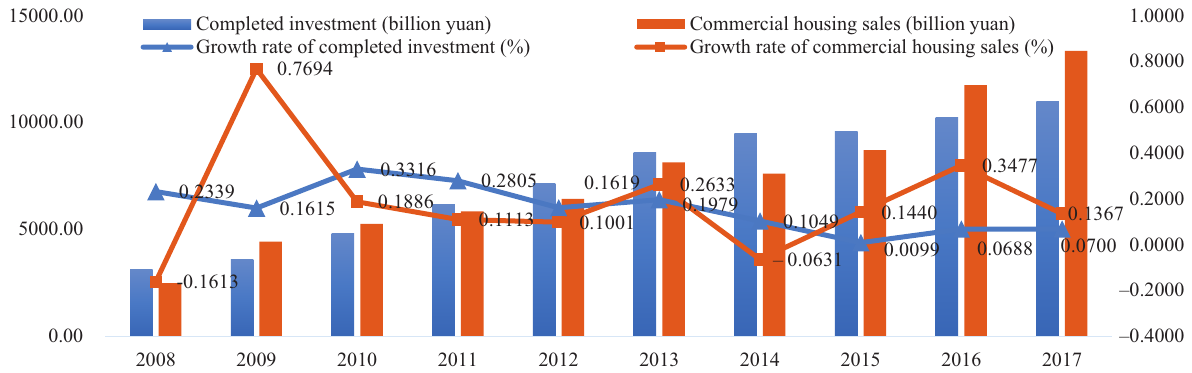
Figure 1. The trend of investment and sales in the real estate industry from 2008 to